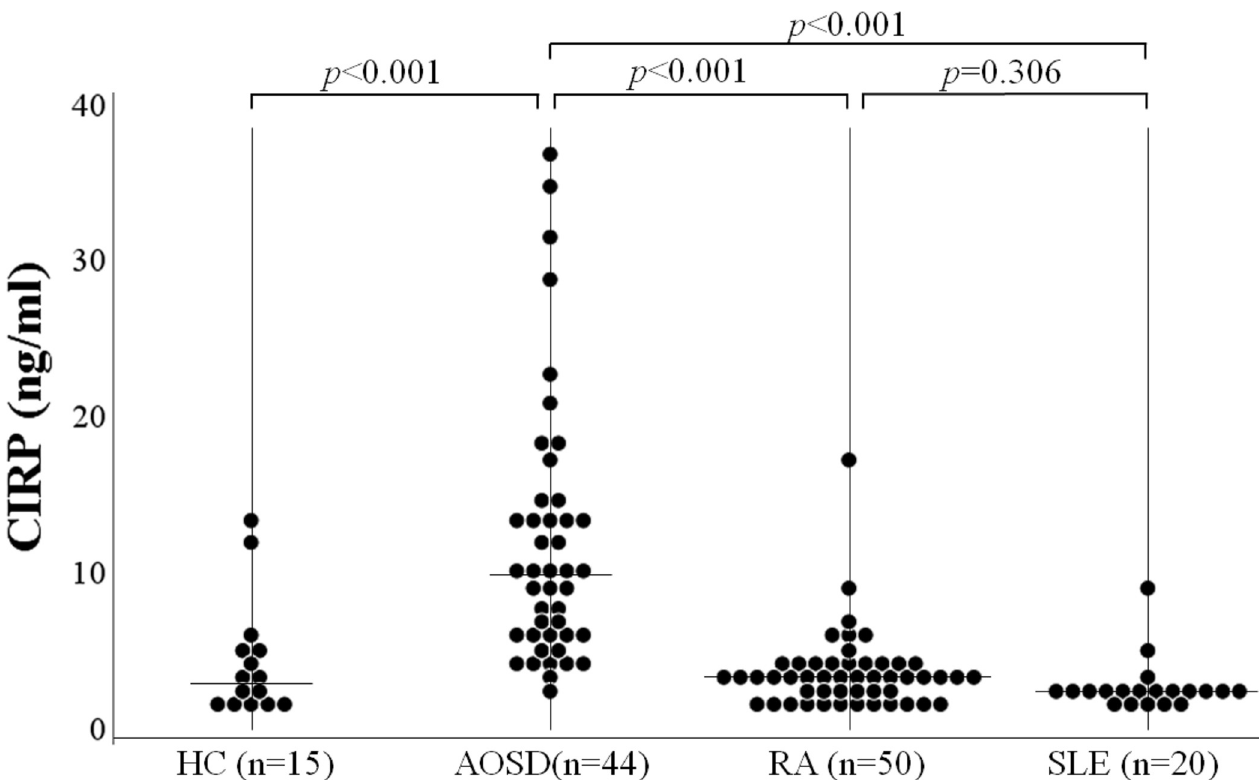
Fig 1. Serum levels of CIRP in patients with AOSD. Serum levels of CIRP in AOSD patients (n = 44) were significantly higher compared to those in RA patients (n = 50), SLE patients (n = 20) or healthy controls (n = 15). Comparisons of serum CIRP levels by Kruskal–Wallis test is significantly different among the four groups ( p < 0.001). Post hoc pairwise analyses between two groups were analyzed by Games-Howell test.